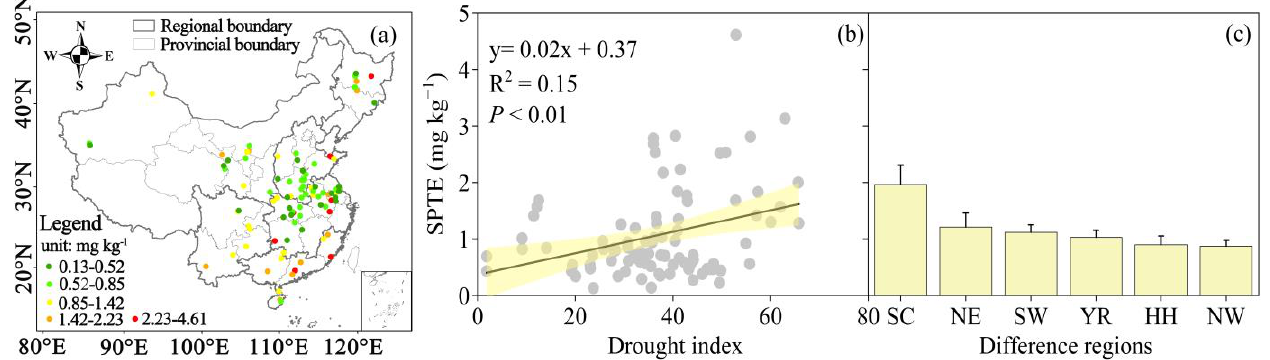
Figure 4. The spatial pattern of national SPTE ( a ), the relationship between SPTE and drought index ( b ), and SPTE at regional scale ( c ) across Chinese cropping systems. Regional abbreviations are as in Figure 1.